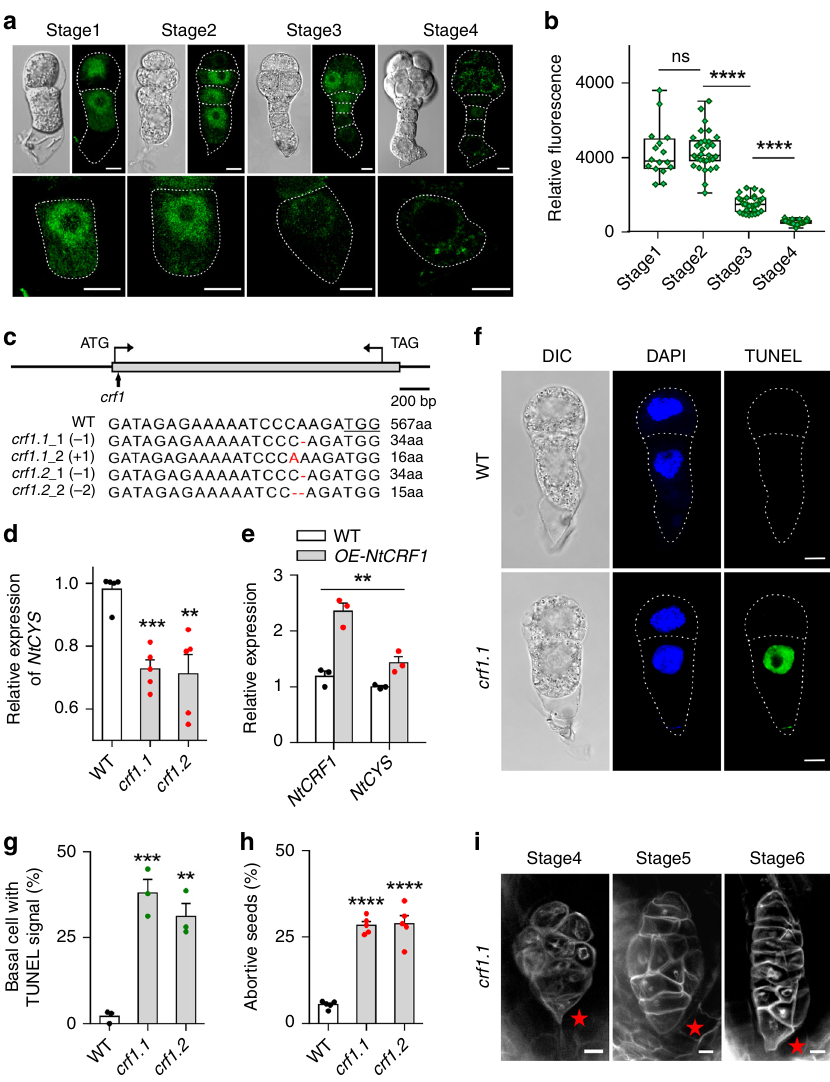
Fig. 2 NtCRF1 promotes NtCYS expression and suppresses PCD in basal cells. a Localization of NtCRF1-GFP during early embryogenesis in pNtCRF1::NtCRF1- GFP plants. Magni fi ed images of corresponding basal SCs are shown below. b Relative fl uorescence intensity of NtCRF1-GFP in basal SCs ( n = 16 – 31). c CRISPR/Cas9-mediated targeted mutagenesis of NtCRF1 . Top: Schematic of NtCRF1 showing the CRISPR/Cas9 target site (arrow). Bottom: Alignment of the sequences showing the insertion or deletion sites (red); numbers, translated amino acids (aa). d Expression of NtCYS was reduced in the crf1 mutants. e Expression of NtCYS is increased in the pNtCRF1::NtCRF1-GFP line ( OE-NtCRF1 ). (Two-way ANOVA, ** P < 0.01). f Nuclear DNA fragmentation in two- celled proembryos of WT and crf1.1 . g Frequency of two-celled proembryos with TUNEL-positive basal cells in WT and crf1 ( n = 98 – 109). h Frequency of aborted seeds in WT and crf1 lines ( n = 200 – 300 seeds per line). i Abnormal suspensors (stars indicated) in crf1 lines by modi fi ed pseudo-Schiff-propidium iodide (PI) staining. Data are the means ± SE of 3 independent experiments in e , g and 5 independent experiments in d , h (Student ’ s t -test, * P < 0.05, ** P